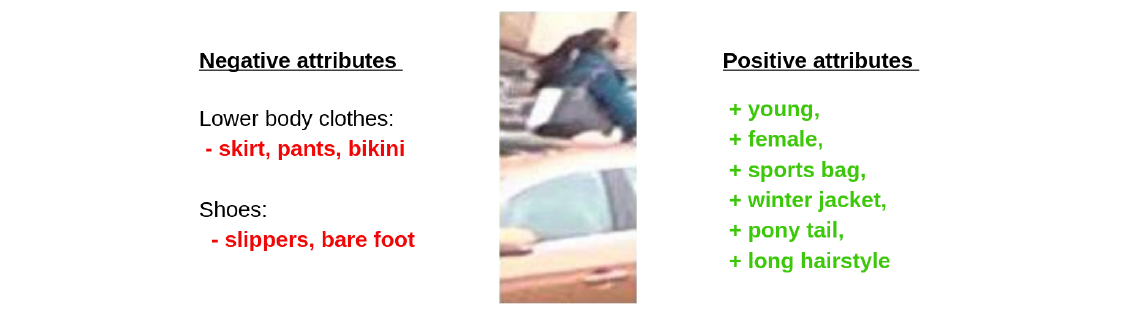
Figure 5. As human, not only we describe the available attributes in occluded images but also we can predict the covered attributes in a negative strategy based on the attribute relations.